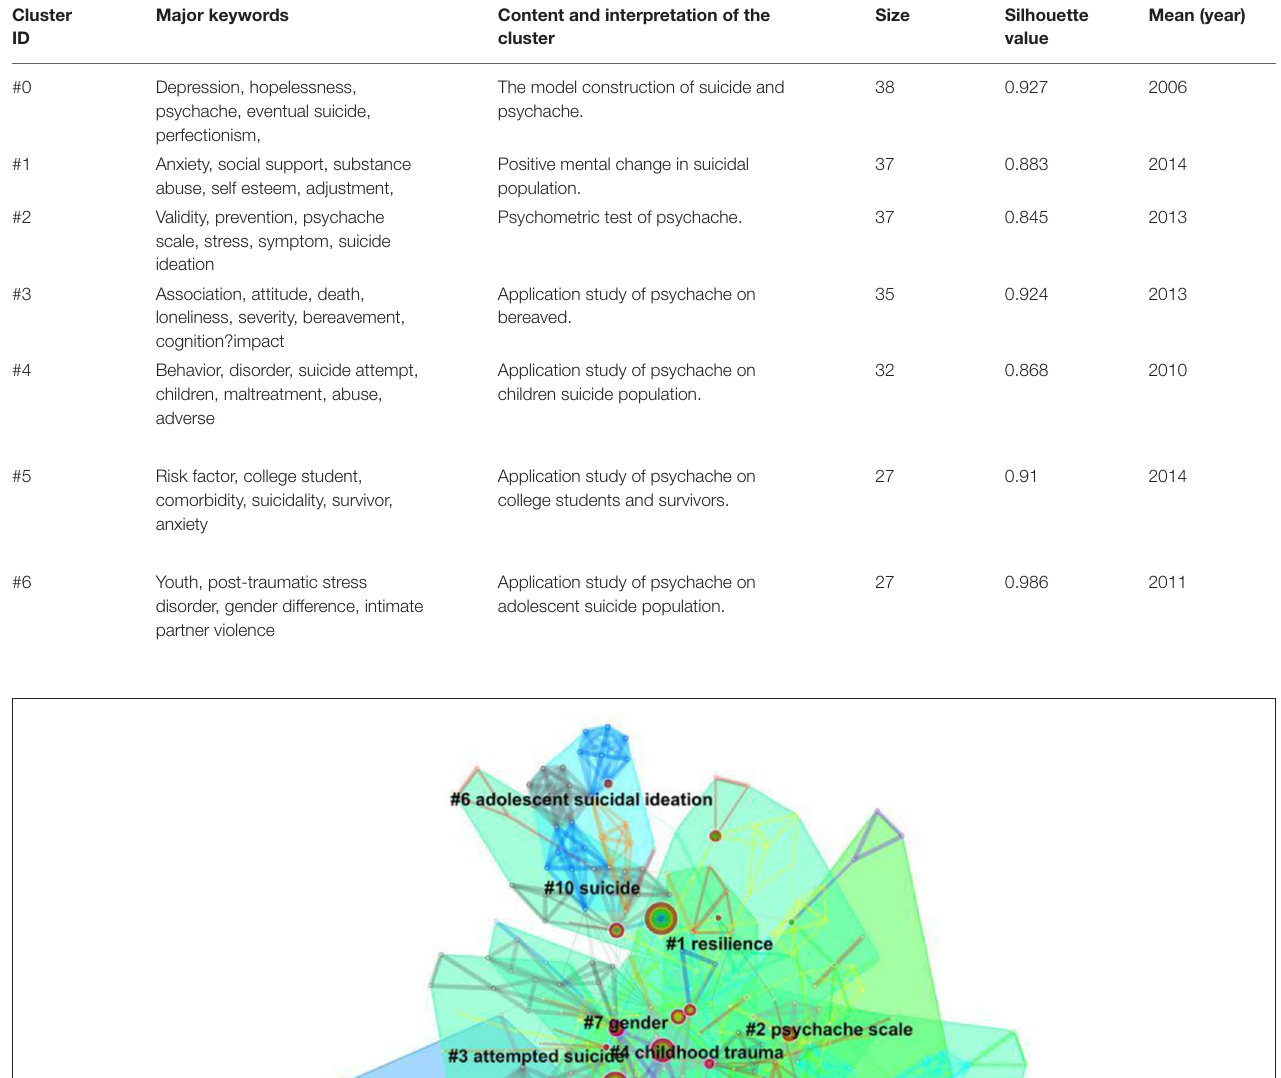
TABLE 4 | The top 7 clusters of keywords for psychache in the suicidology during 1994–2020. Cluster ID